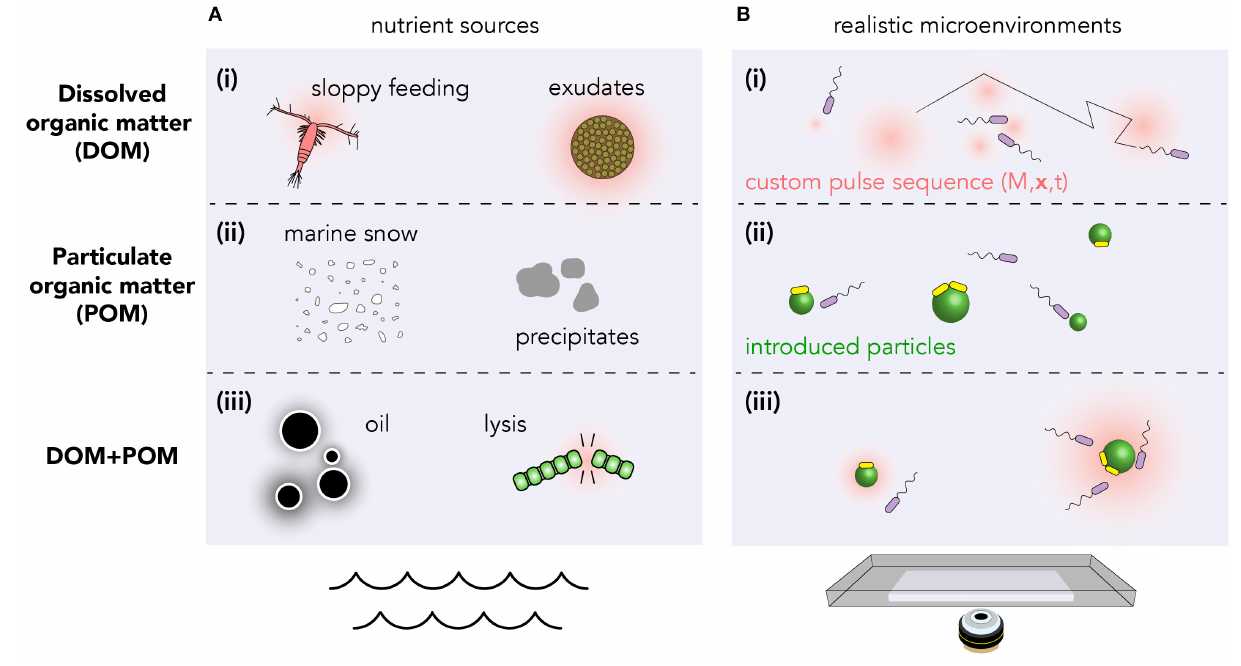
Frontiers in Marine Science |